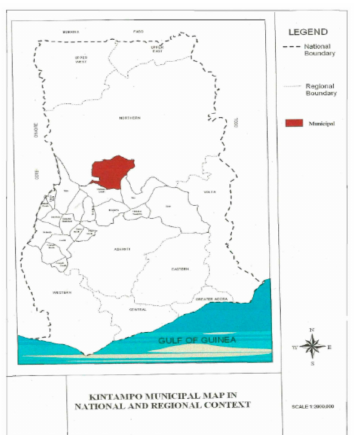
Figure 1. Map of Ghana showing Kintampo North